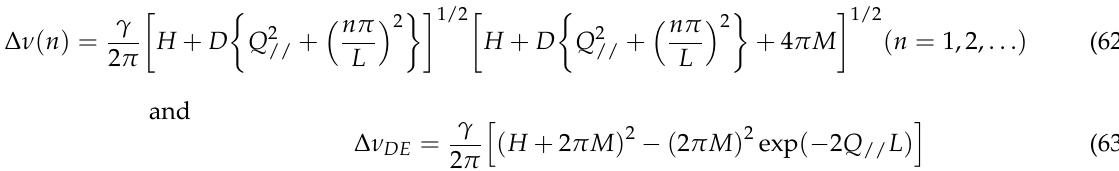
Figure 8. Magnetic field dependence of the SSW and DE mode frequencies. The open symbols and + symbol are for the SSW modes, and ( • ) is for the DE mode. Here, the labels 1 to 5 stand for the SSW mode number. The solid and broken lines were calculated from Equations (59) and (60) with the magnetic constants given in the text (Copyright (1994) The Japan Society of Applied Physics) [62]. The open symbols stand for the SSWs, and the filled circles stand for the DE